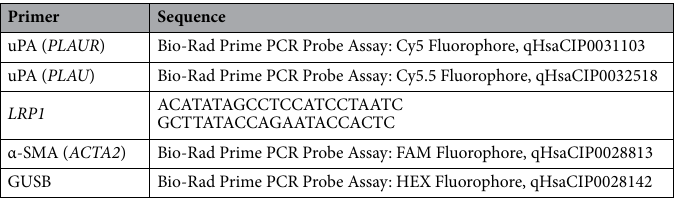
Table 2. Includes the reference information for the genes used in the detailed qPCR